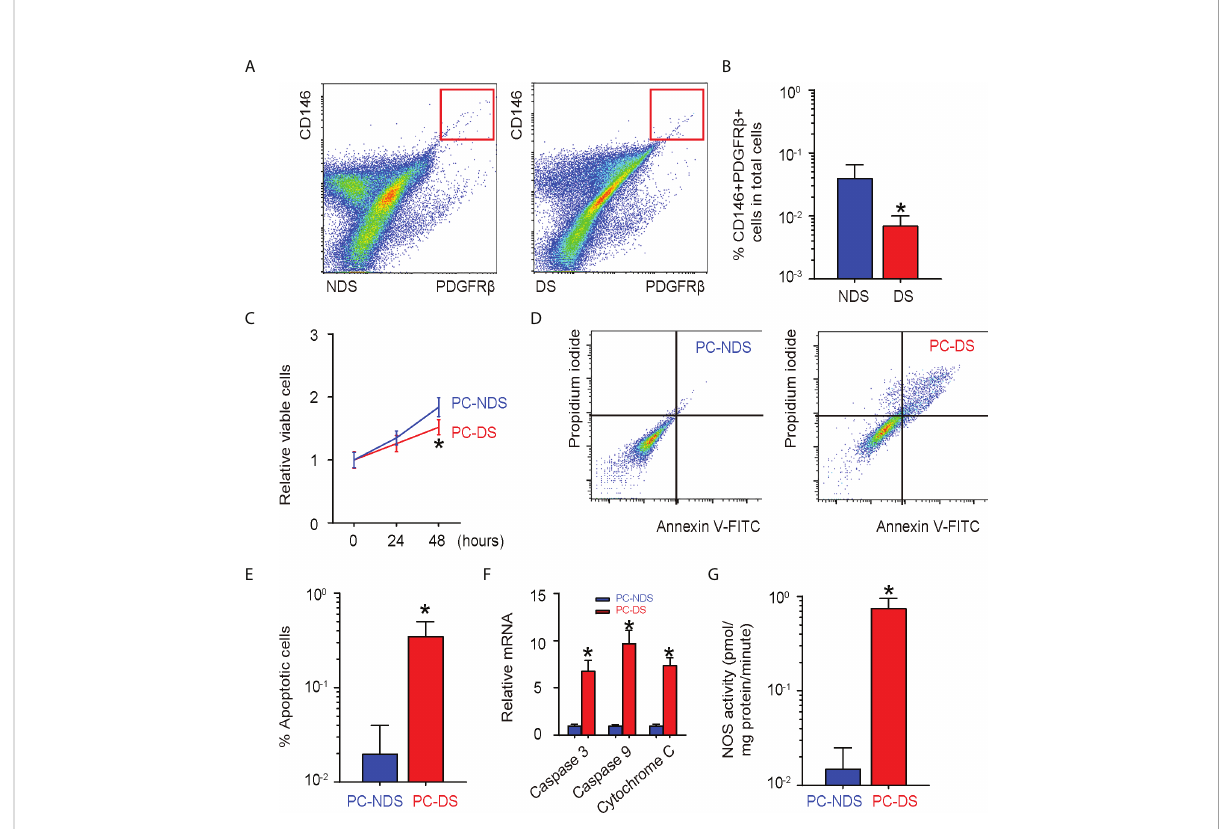
FIGURE 1 Pericytes from wound skin of diabetic patients are impaired (A, B) Wound tissues obtained from non-diabetic wound skin (NDS) and diabetic wound skin (DS) were digested into single cells that underwent fl uorescence-activated cell sorting (FACS) for CD146 and platelet-derived growth factor b (PDGFR b ) to isolate CD146+PDGFR b + pericytes, shown by representative fl owcharts (A) and by quanti fi cation (B) . (C) CCK-8 assay for pericytes isolated from NDS (PC-NDS) and NS (PC-NS). (D,E) An annexin V apoptosis assay by representative fl owcharts (D) and by quanti fi cation (E) . (F) RT-qPCR for apoptosis-associated protein Caspase 3, Caspase 9, and Cytochrome 9. (G) NOS activity. * p < 0.05. N =